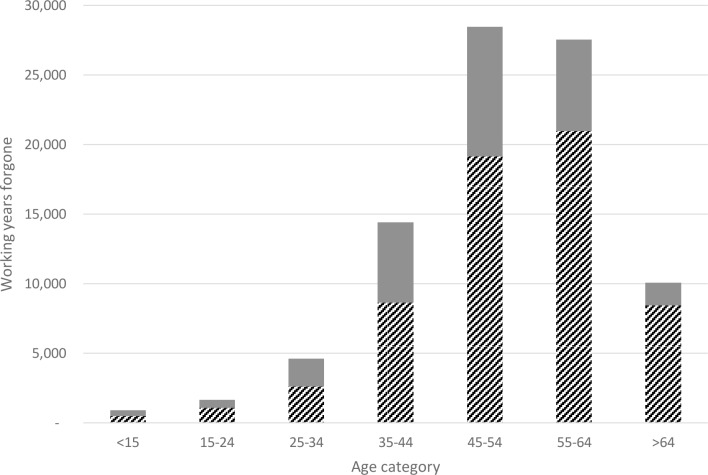
Working years forgone due to premature mortality from cancer in 2003, modelled to the year 2030.Hatched bar, males; solid bar, females.